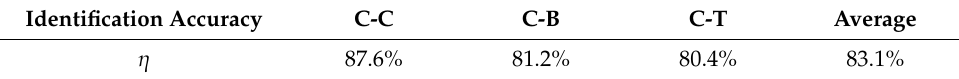
Table 4. Identification accuracy under dynamical conditions.